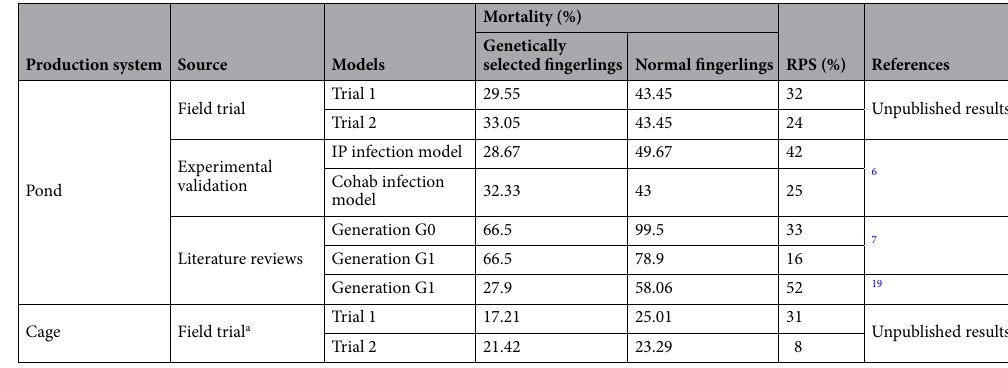
Table 2. Different sources of information on relative percent survival (RPS) related to the use of genetically selected Nile tilapia fingerlings resistant to Streptococcosis in the pond and cage culture system. Most probable value for the Pert distribution is calculated from the mean of all available RPS values in the Table. IP is intraperitoneal and cohab is cohabitation infection model. a Both genetically selected and normal fingerlings were vaccinated during the experiment to mimic the cage culture practice of vaccinating the fish as stated in the text.